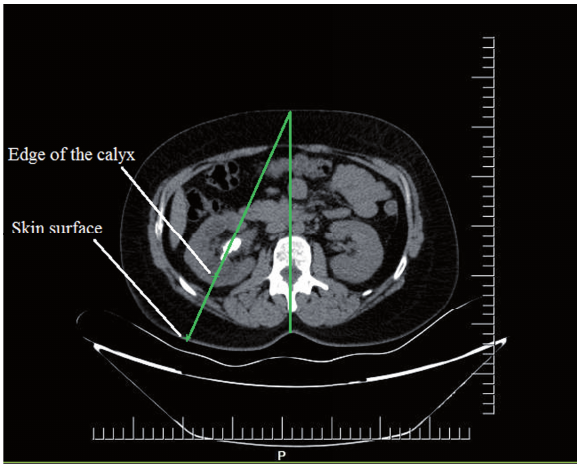
figure 1- Example of an axial image from a cT scan, demonstrating the way 'skin to calyx